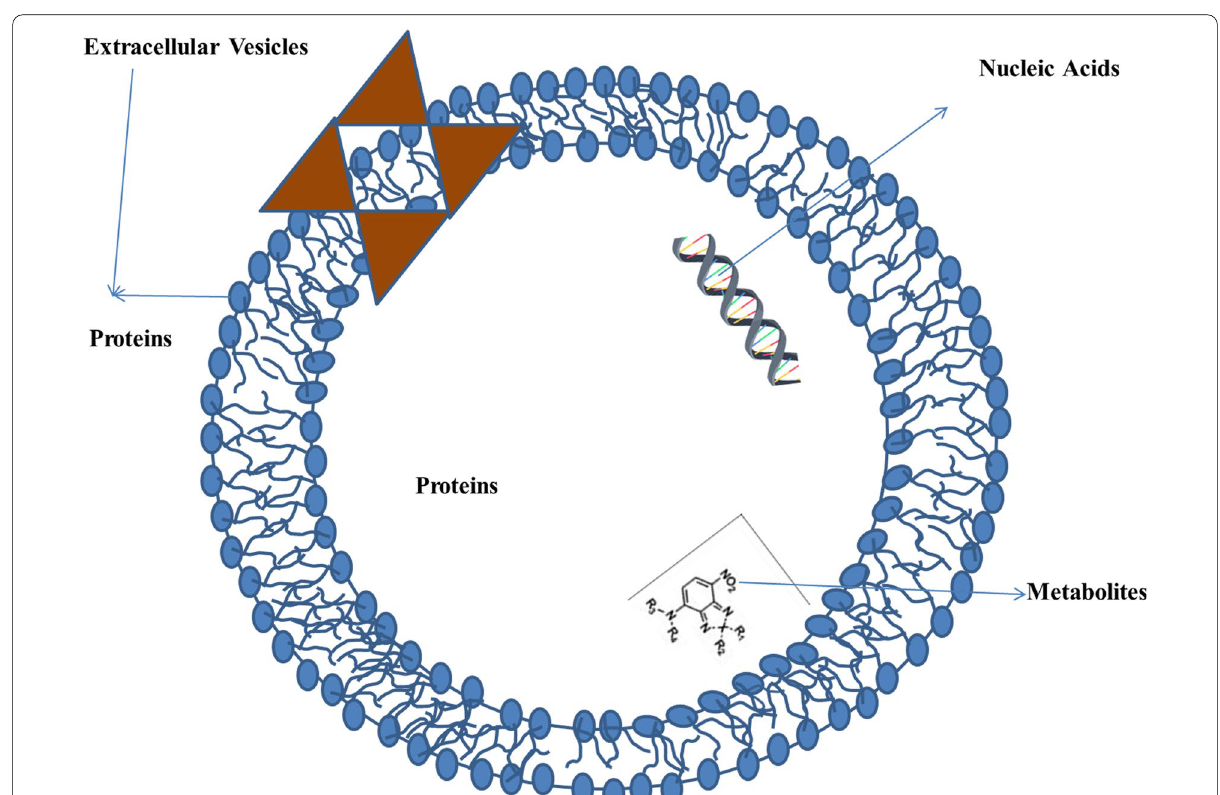
Fig. 2 Schematic representation of